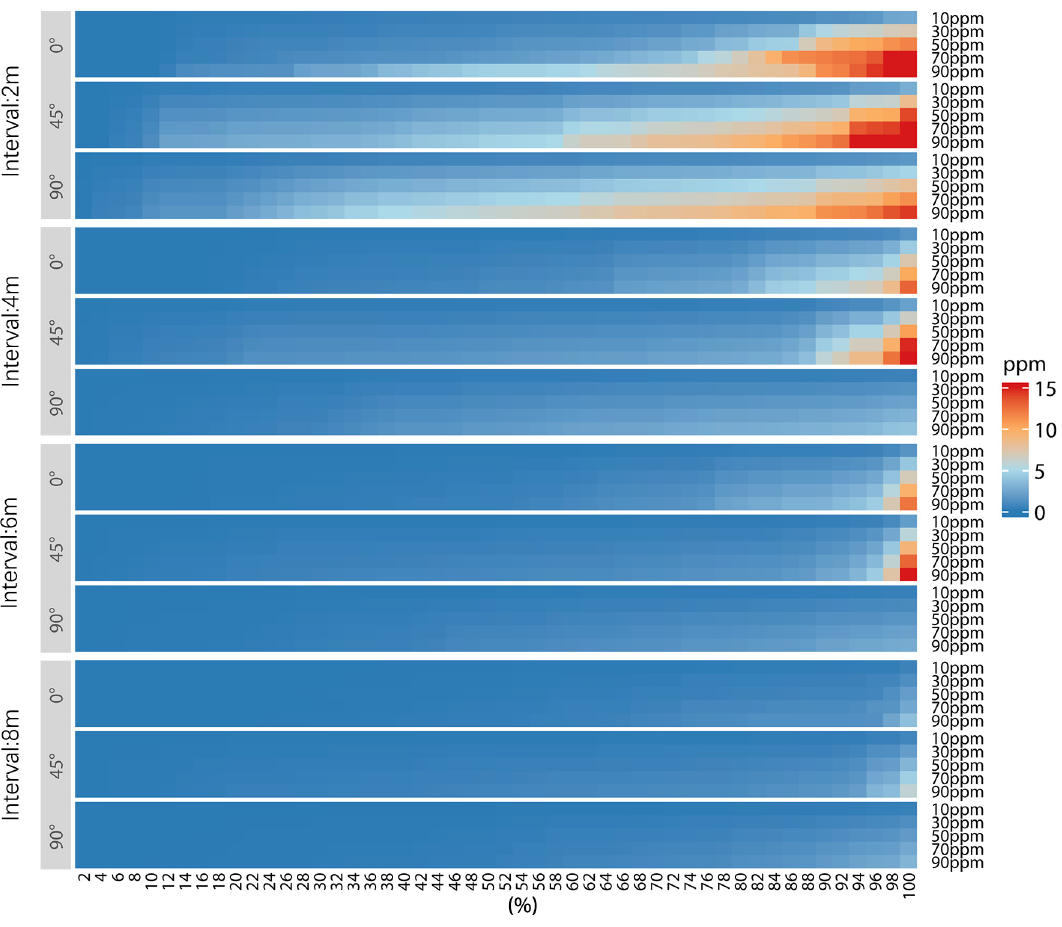
Figure 10. Percentage map of ammonia concentration at sampling points.